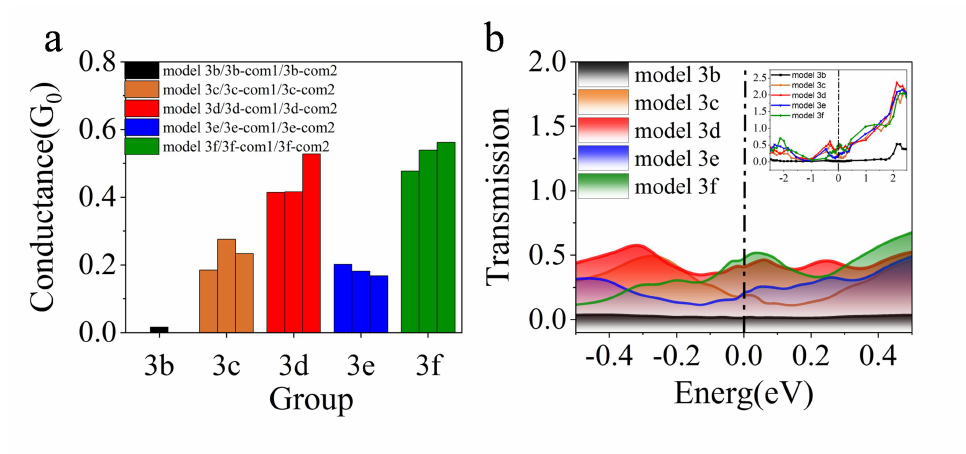
Figure 2. Conductance, transmission spectrum analysis, and local density analysis of different models. ( a ) comparison of zero-bias conductance among different defect models. Bars of the same color represent the same group of models; ( b ) transmission spectrum comparison of different vacancy models near the Fermi level. Inset shows the transmission spectrum from − 4 eV to 4